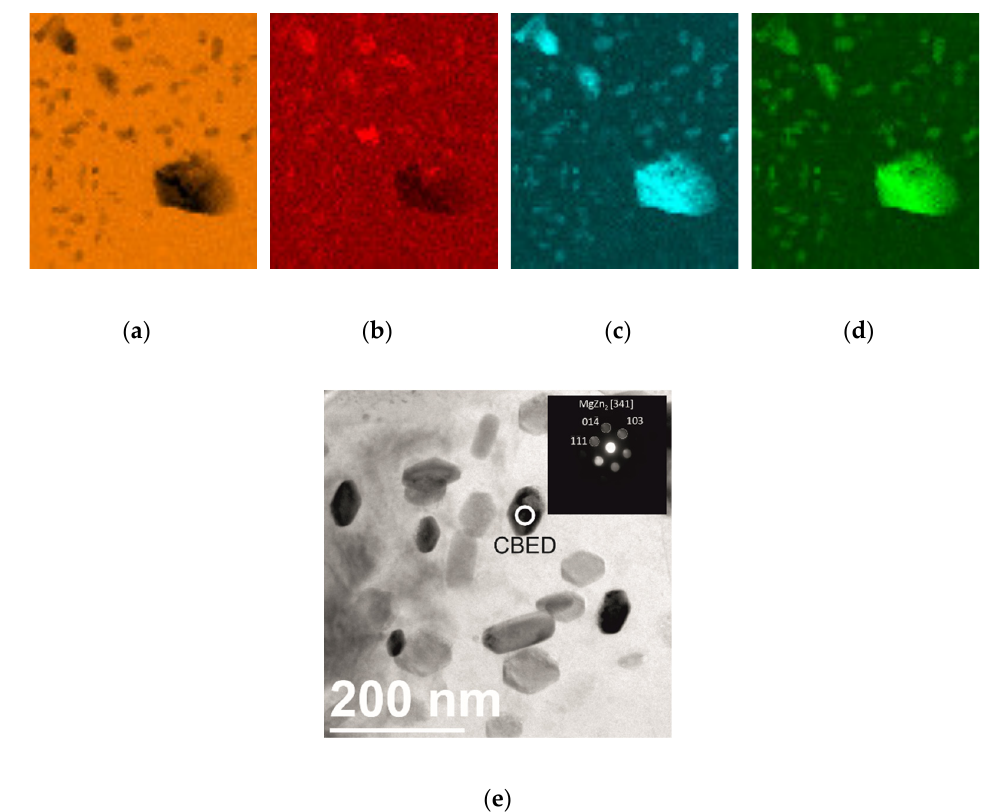
Figure 8. EDX elemental mapping of SPS-KOBO extruded AA7075: aluminium ( a ); magnesium ( b ); zinc ( c ); copper ( d ); BF-TEM micrograph ( e ). Inset of Figure 8e presents CBED pattern of second phases. Table 3. Chemical composition of precipitates in various areas presented in Figure 7b.